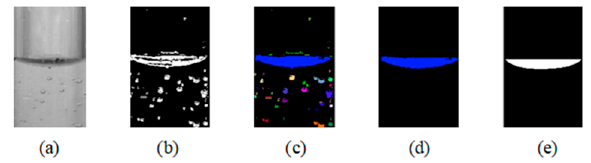
Figure 15. The extraction of standard concave liquid level images, including ( a ) the adaptive gray image, ( b ) the edge detection image, ( c ) the outline image, ( d ) the maximum outline, and ( e ) the smoothness processing image.